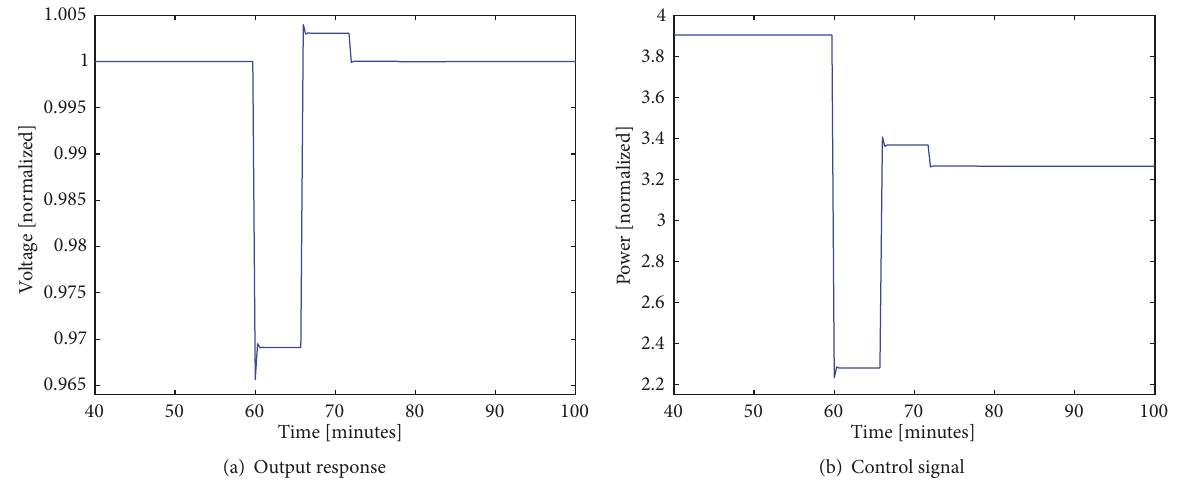
Figure 19: Detailed system response of the adaptive control